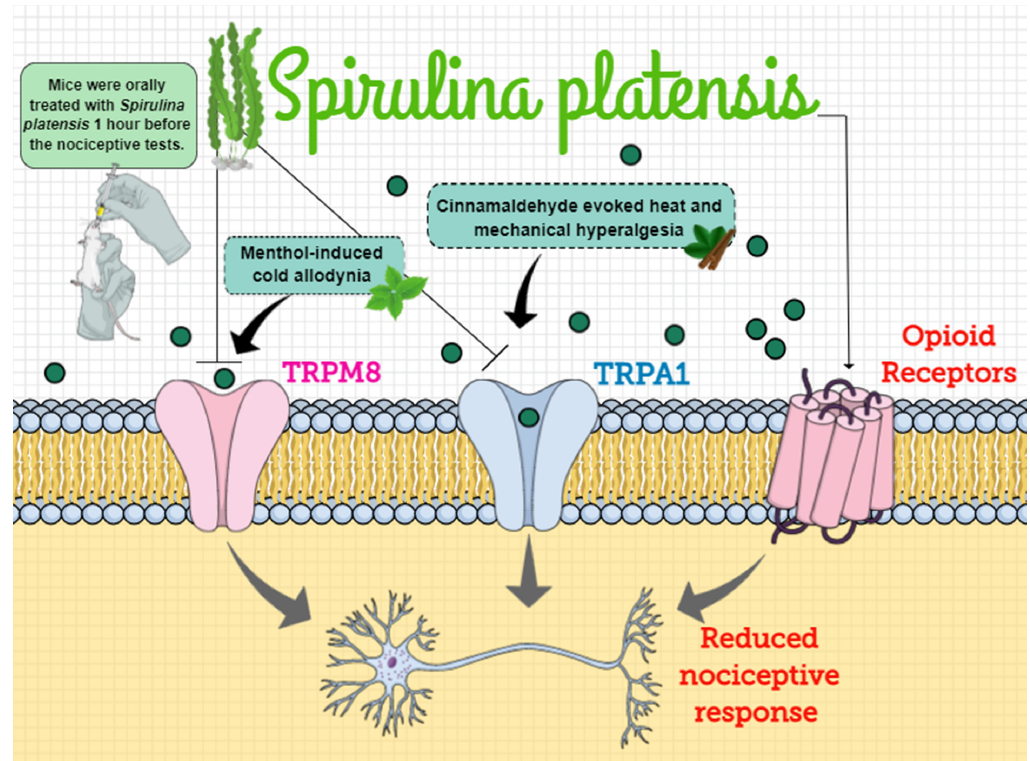
Figure 8. The mechanisms of action behind the antinociceptive effects of Spirulina platensis . Spirulina belongs to a group of aquatic organisms named blue-green algae and to the phylum Cyanobacteria. Considering that the use of this algae is widespread among people due to its diverse biological activities, herein, we demonstrated the possible mechanism of action by which Spirulina could exert its antinociceptive effects in mice submitted to different models of acute nociceptive response. Our results demonstrated that Spirulina markedly decreased cold-allodynia, heat, and mechanical hyperalgesia through inhibition of TRPM8 and TRPA1 ion channels’ activation by their respective agonists—menthol and cinnamaldehyde. Additionally, we also reported that naloxone reversed the antinociceptive effect of Spirulina during the formalin test, which suggests that the analgesic effect of Spirulina seems to be mediated, at least partially, by the opioid system. Thus, it is possible to hypothesize that Spirulina exerts antinociceptive effects during inflammatory models by modulation of TRPM8/TRPA1 channels and endogenous opioids signaling pathways. TRPM8: transient receptor potential cation channel subfamily M (melastatin) member 8; TRPA1: transient receptor potential ankyrin 1 channel.